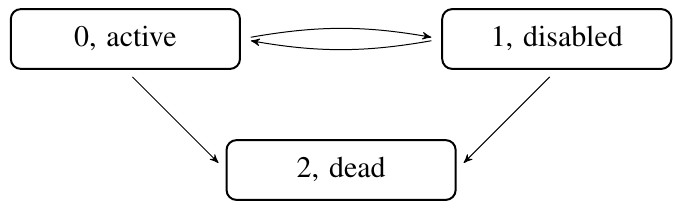
Figure 5. Disability Markov